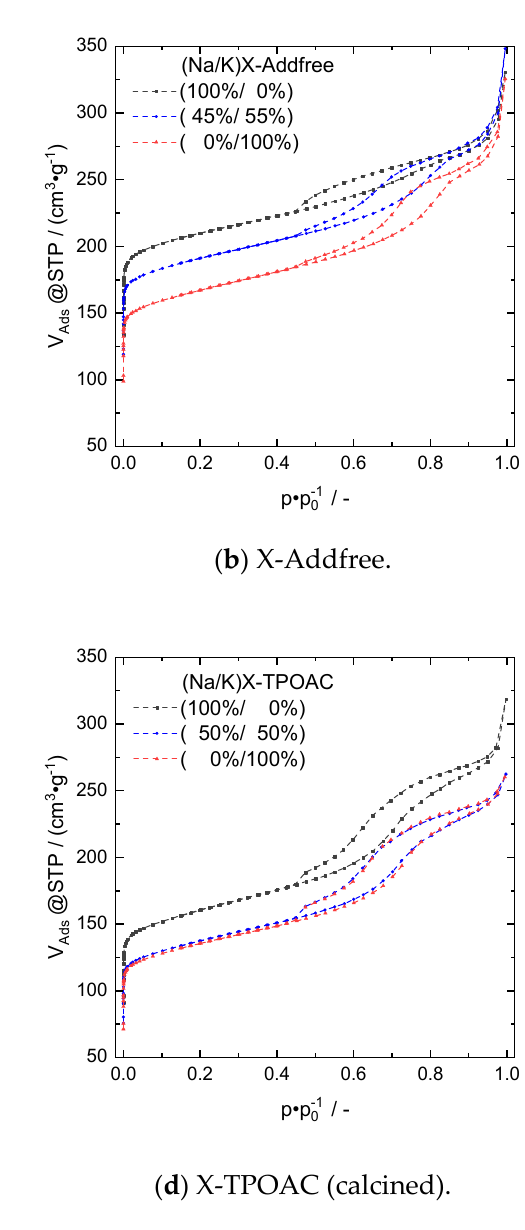
Figure 3. Nitrogen physisorption isotherms of the zeolite X materials with conventional morphology ( a ), layer-like morphology via temperature reduction ( b ), layer-like morphology due to the addition of Li 2 CO 3 ( c ), and the addition of the organosilane TPOAC ( d ). Each zeolite is shown before and after the first ion exchange and after the sixth ion